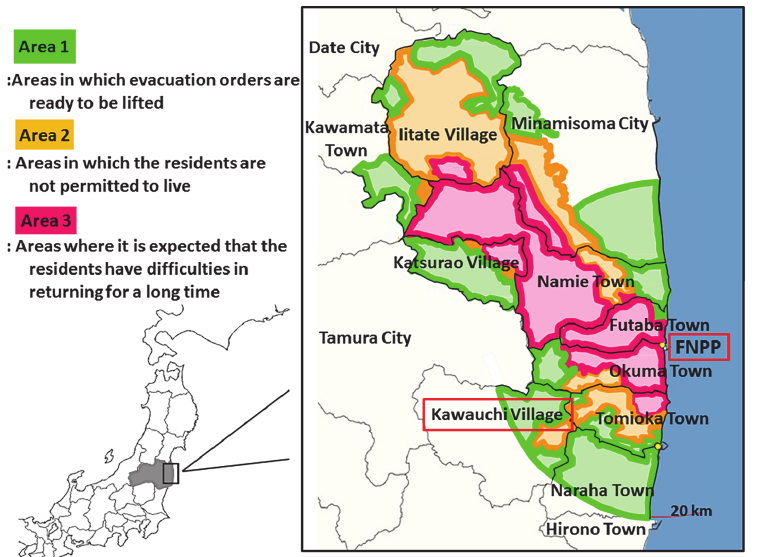
Fig 1. The Status of evacuation order areas in Fukushima